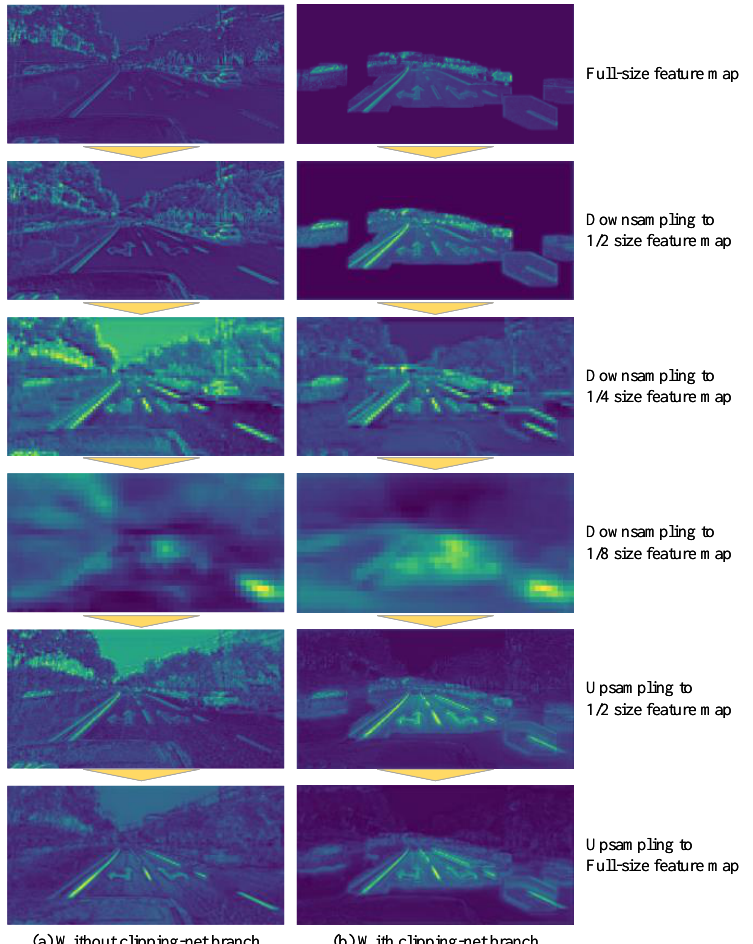
Figure 10. The feature maps of different sizes output by convolutional layers of different depths in the network. ( a ) Our network without Dlipping-net branch: the input of the network is only the complete image of the current frame. Some convolution kernels react to many non-target features, resulting in features near lanes and road markers being difficult to be extracted correctly by the network. ( b ) Our network with Clipping-net branch: the inputs of the network not only include the complete image of the current frame, but also the cropped image of the current frame. Obviously, the Clipping-net branch can inhibit the activation of the convolutional kernels in the background. Convolutional kernels almost never react to non-target features, and most of the activated neurons are concentrated near the target. Compared with ( a , b ) can extract the features near lanes and road markers